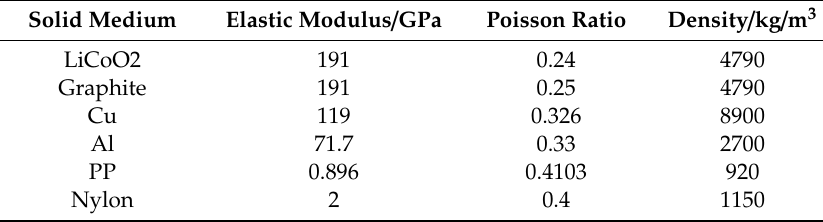
Table 3. The material properties of the solid domain.